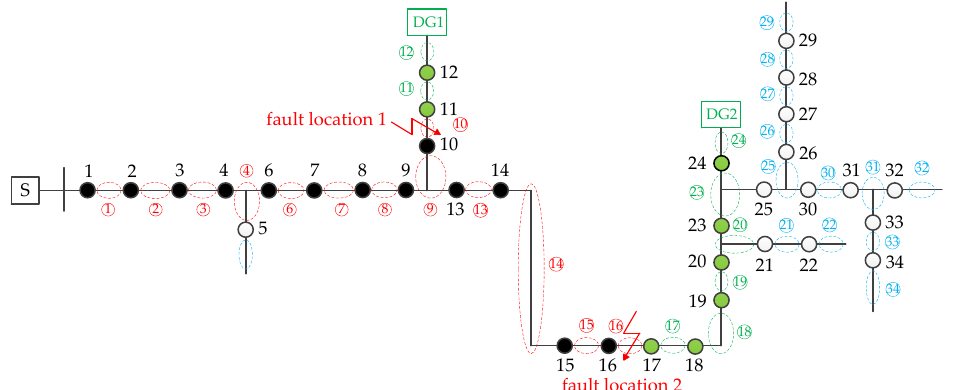
Figure 9. Multiple faults in the IEEE-34 node distribution network with distribution generations (DGs). Table 6. The line list of Figure 9.